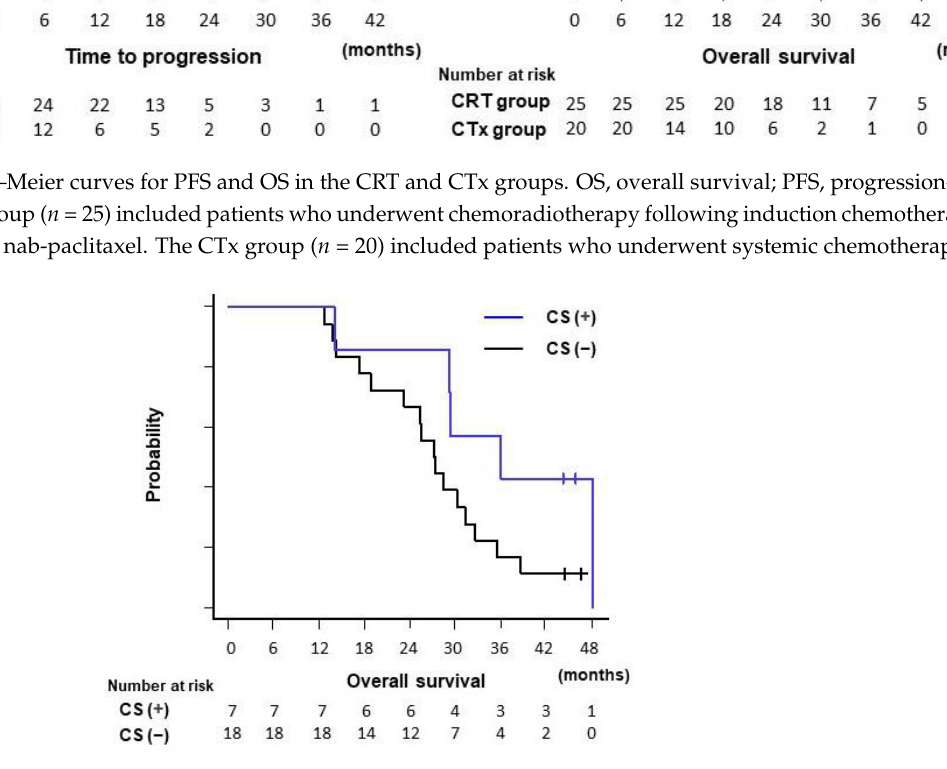
Figure 3. A comparison of overall survival between patients who underwent CS and those who did